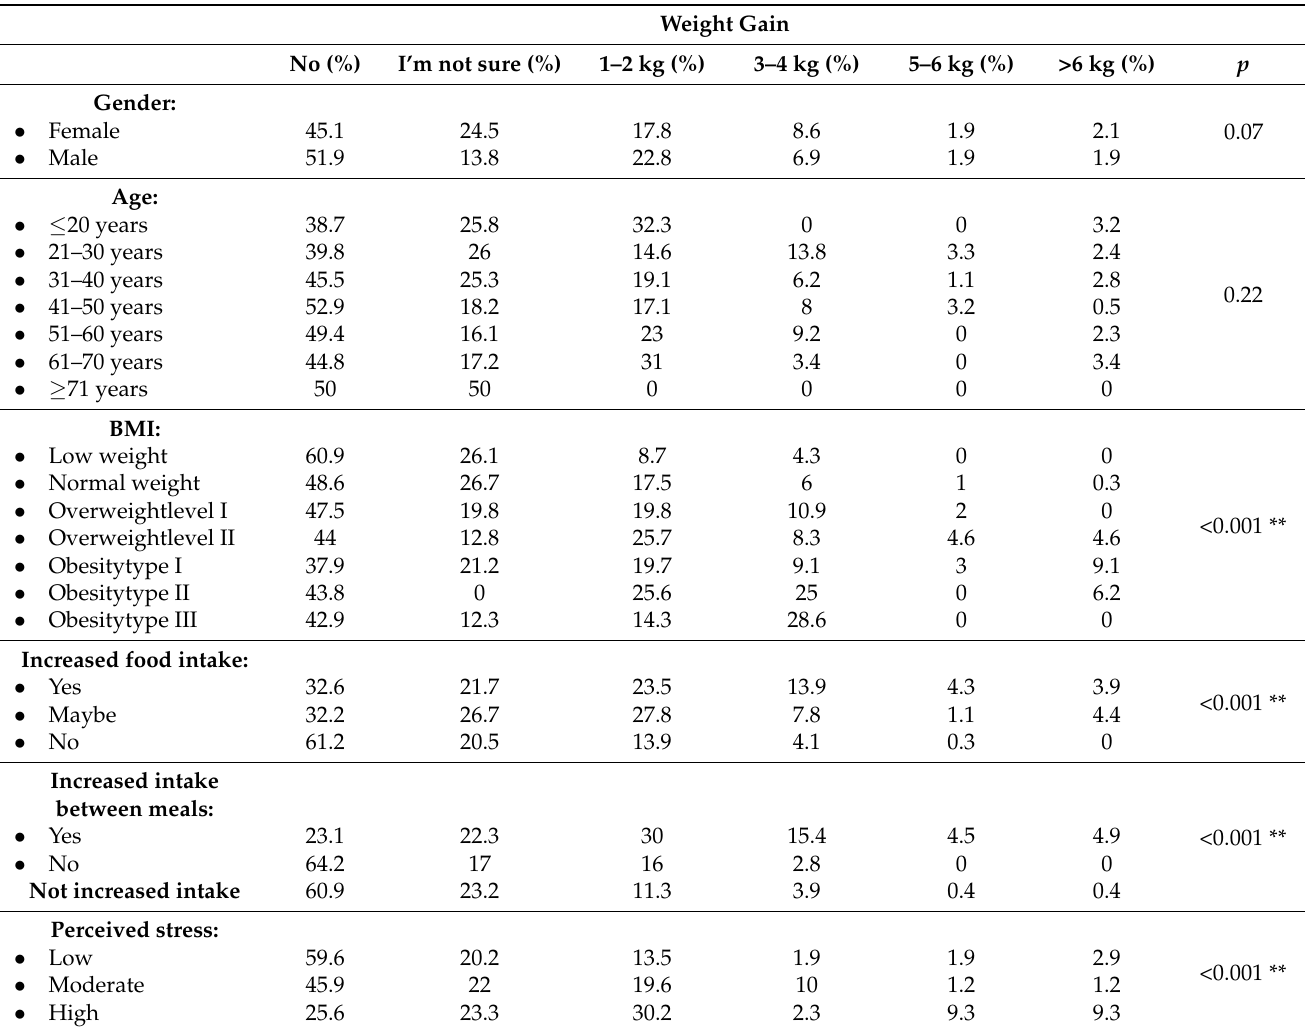
Table 6. Assessment of weight-gain during the ‘third wave’ of the pandemic in Spain. Weight